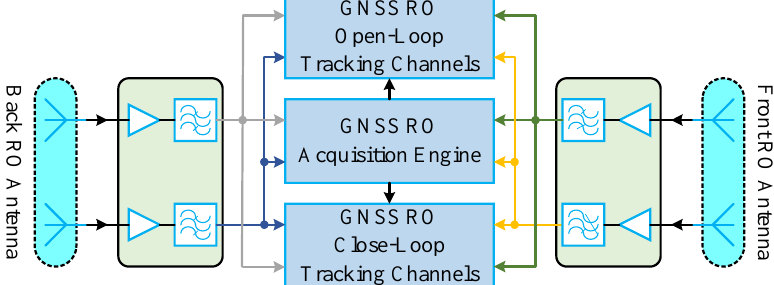
Figure 3. Signal processing structure of the GNSS RO module in the SIGRS.